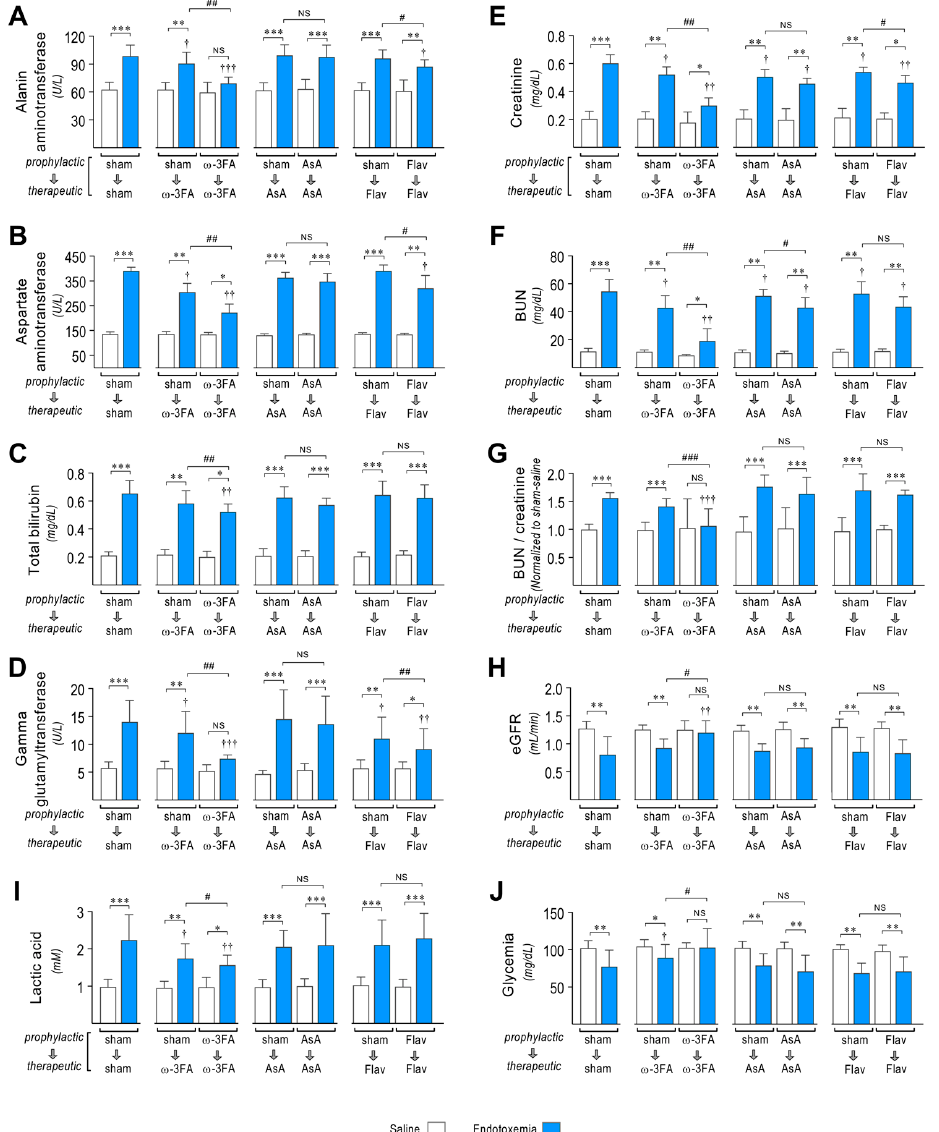
Figure 7. Effects in MODS through dietary supplementation based on ω -3 FA, ascorbic acid, or polyphenolic antioxidant flavonoids in endotoxemic rats. After saline (open bars) and endotoxemia (blue bars) treatments that were supplemented with water (sham), ω -3 fatty acid ( ω -3 FA), ascorbic acid (AsA), or polyphenolic antioxidant flavonoids (Flav), through a therapeutic and a prophylactic protocol, the blood levels of the liver dysfunction markers alanine aminotransferase (ALT, ( A )), aspartate aminotransferase (AST, ( B) ), total bilirubin (TBIL, ( C )), and gamma-glutamyl transferase (GGT, ( D )); renal dysfunction markers creatinine (CRE, ( E )) and blood urea nitrogen (BUN, ( F )); BUN/Creatinine ratio ( G ); estimated GFR (eGFR, ( H )); and the metabolic dysfunction markers lactic acid (LAC, ( I )) and glycemia (GLY, ( J )) were measured. Statistical differences were assessed by two-way ANOVA followed by Dunnett’s post hoc test. * p < 0.05; ** p < 0.01; *** p < 0.001 comparing saline and endotoxemia condition. † p < 0.05, †† p < 0.01, ††† p < 0.001 compared with sham-treated condition. # p < 0.05; ## p < 0.01; ### p < 0.001 comparing non-survivor endotoxic condition between therapeutic and prophylactic protocol. NS: non-significant. Results are expressed as the mean ± SD ( N =